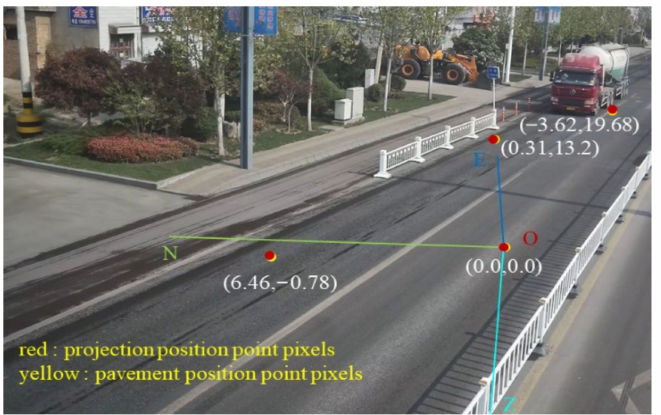
Figure 5. Road surface Coordinate system and reference